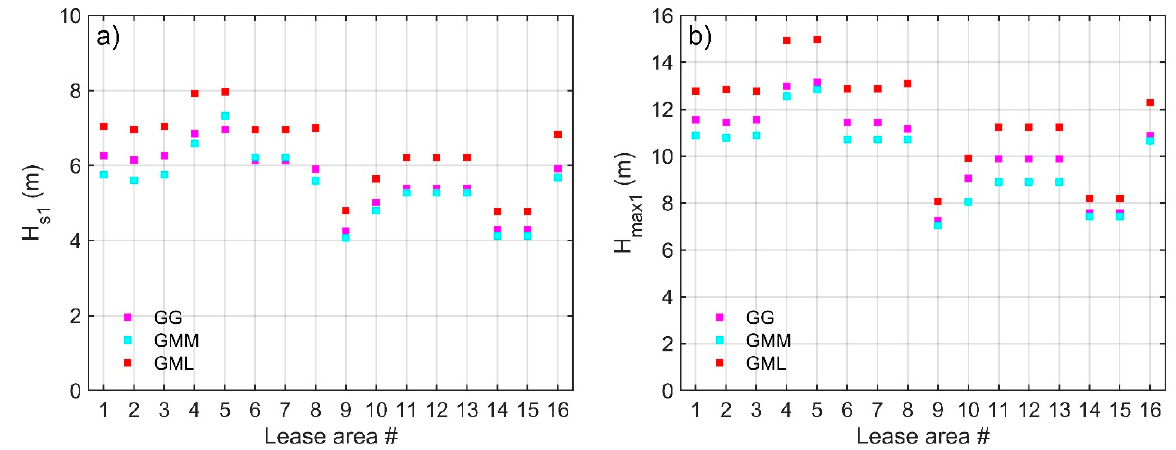
Figure 11. The 1-year return period estimates of ( a ) H s and ( b ) H max over the 16 LA from the different distribution fitting approaches.